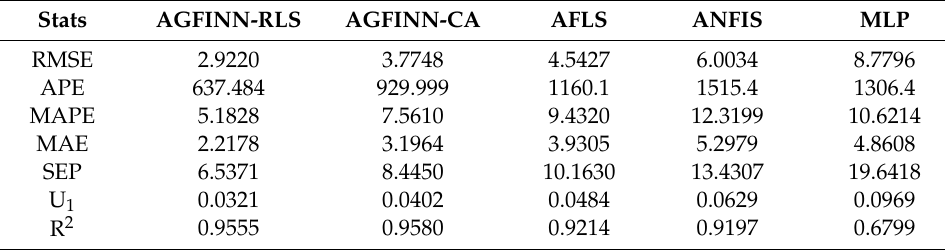
Table 4. Statistical performances for electricity price forecasting models at 04:00—case study